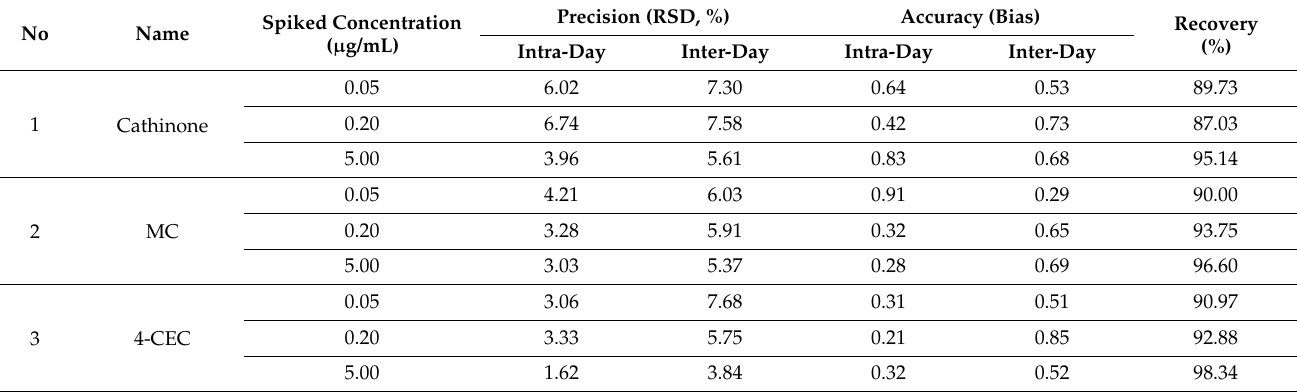
Table 5. Precisions and recoveries of 16 kinds of synthetic cathinones in human